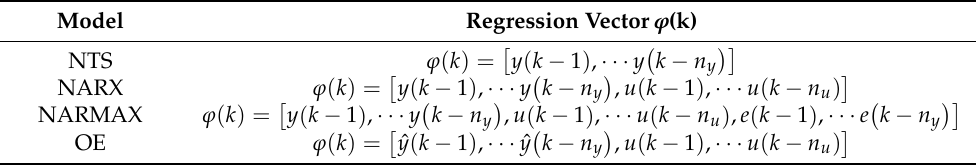
Table 1. Structures of regression vectors for common input/output models.